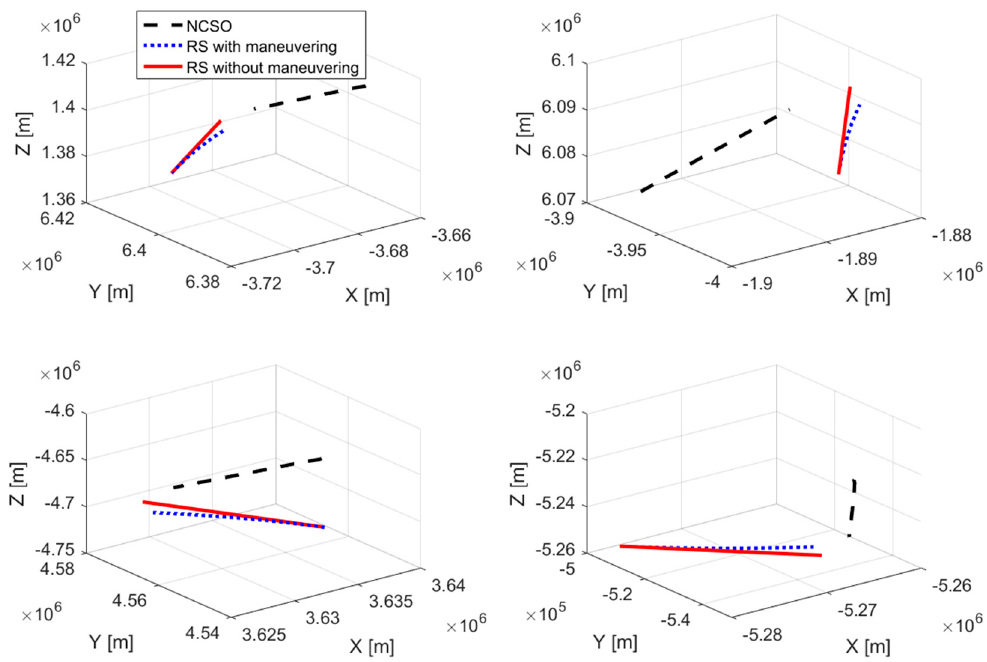
Figure 12. Simulated orbits of NCSO and RS (four sets of simulation).